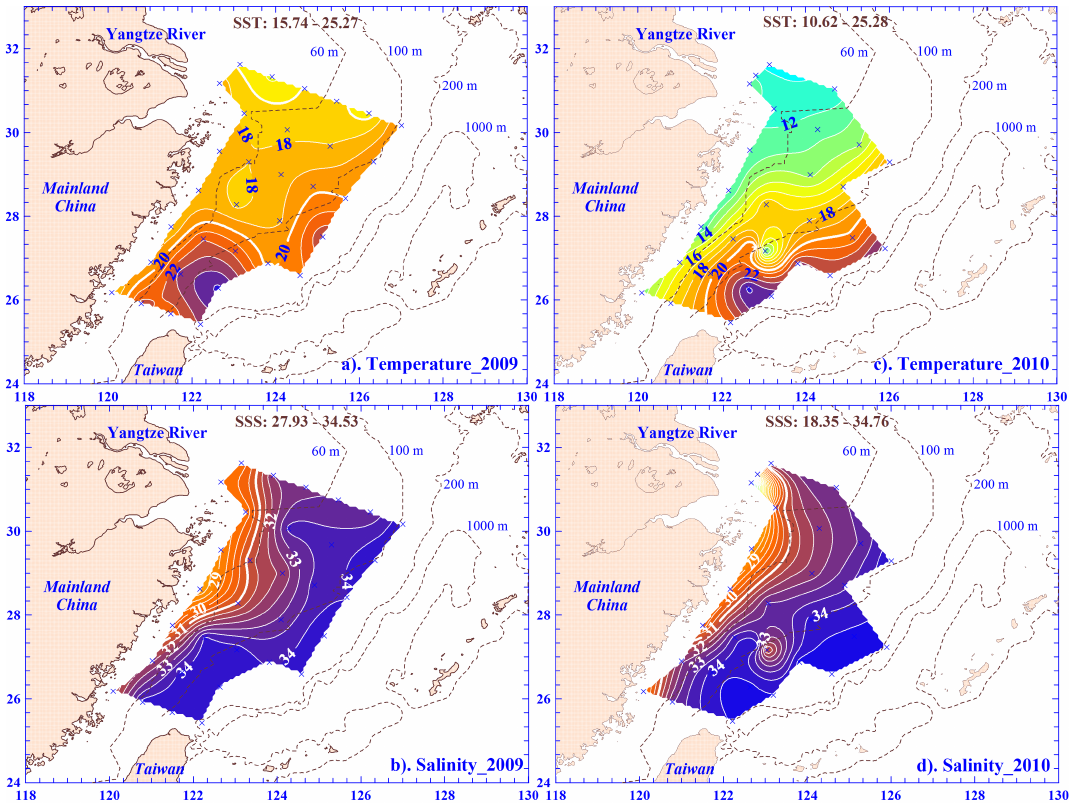
Fig. 2. Contour plots of surface seawater temperature (SST) and salinity (SSS) of the ECS in 2009 (a) , (b) and 2010 (c) , (d) , with contour lines of SST = 20 ◦ C and SSS = 31 were bolded for reference. Contour intervals of temperature and salinity are 1 ◦ C and 0.5,